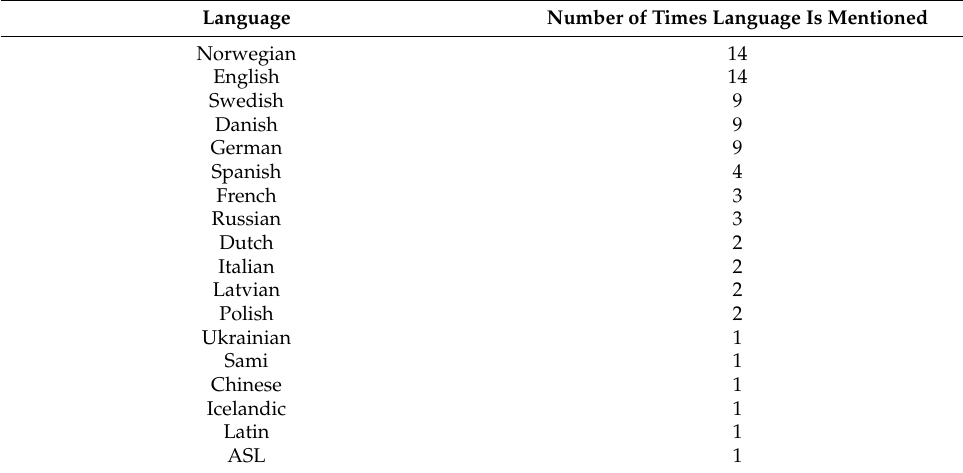
Table 2. Number and frequency of languages